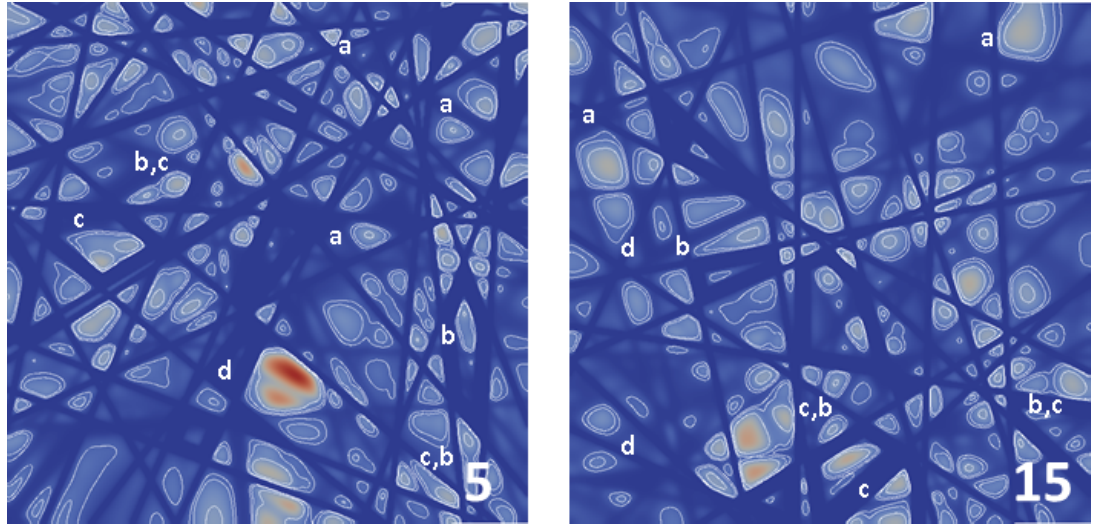
Figure 4. Velocity at the GDL/channel interface for realization Nos. 5 and 15. Mass-related quantiles for q = 70%, 50%, and 20%. Labels “a”–“d” are described in Section